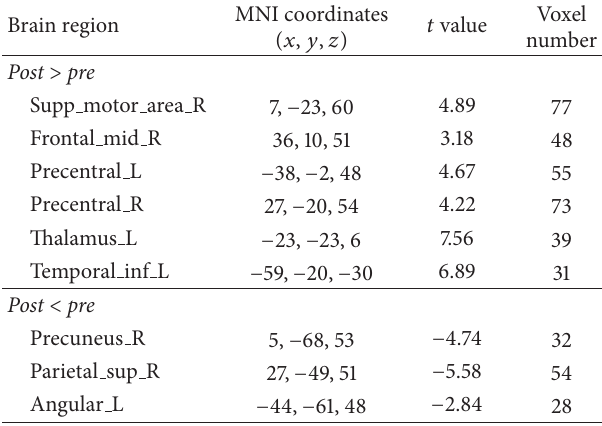
Table 3: Brain regions with significant clusters and peak voxel coordinatesshowingFAdifferencebetweenrTMSgroupandcontrol